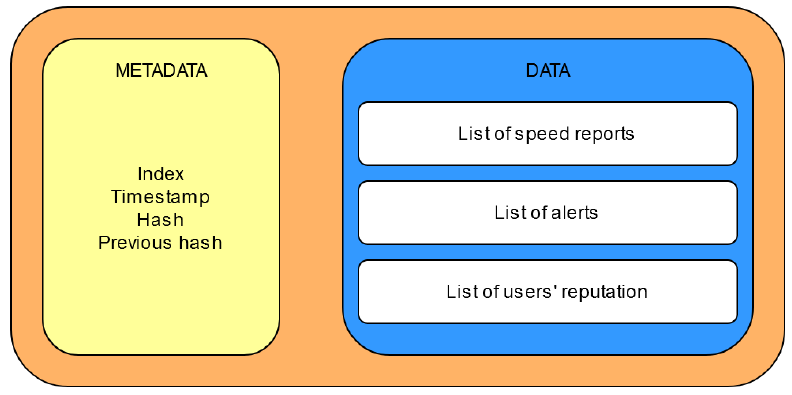
Figure 11. Block